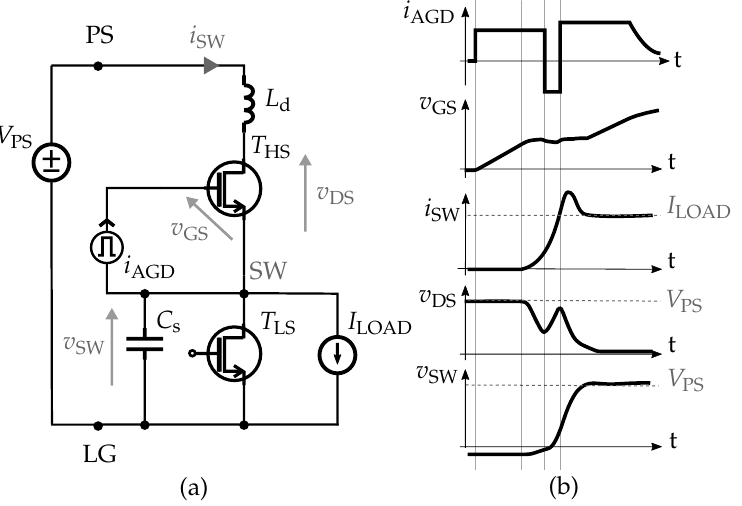
Figure 5. ( a ) Simplified model of a single leg for the analysis of the turn-on when the high-side tran- sistor is driven by an active gate driver generating a current modulation, and ( b ) the corresponding switching